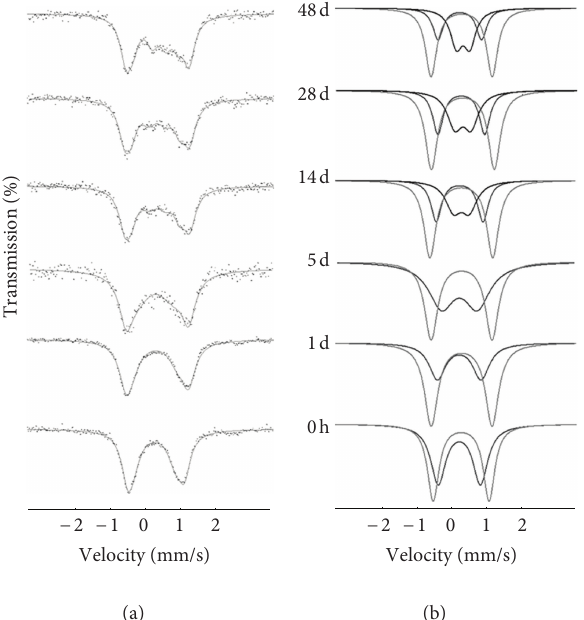
F 6: Mössbauer spectra of cement PC2 at different ages of hydration.